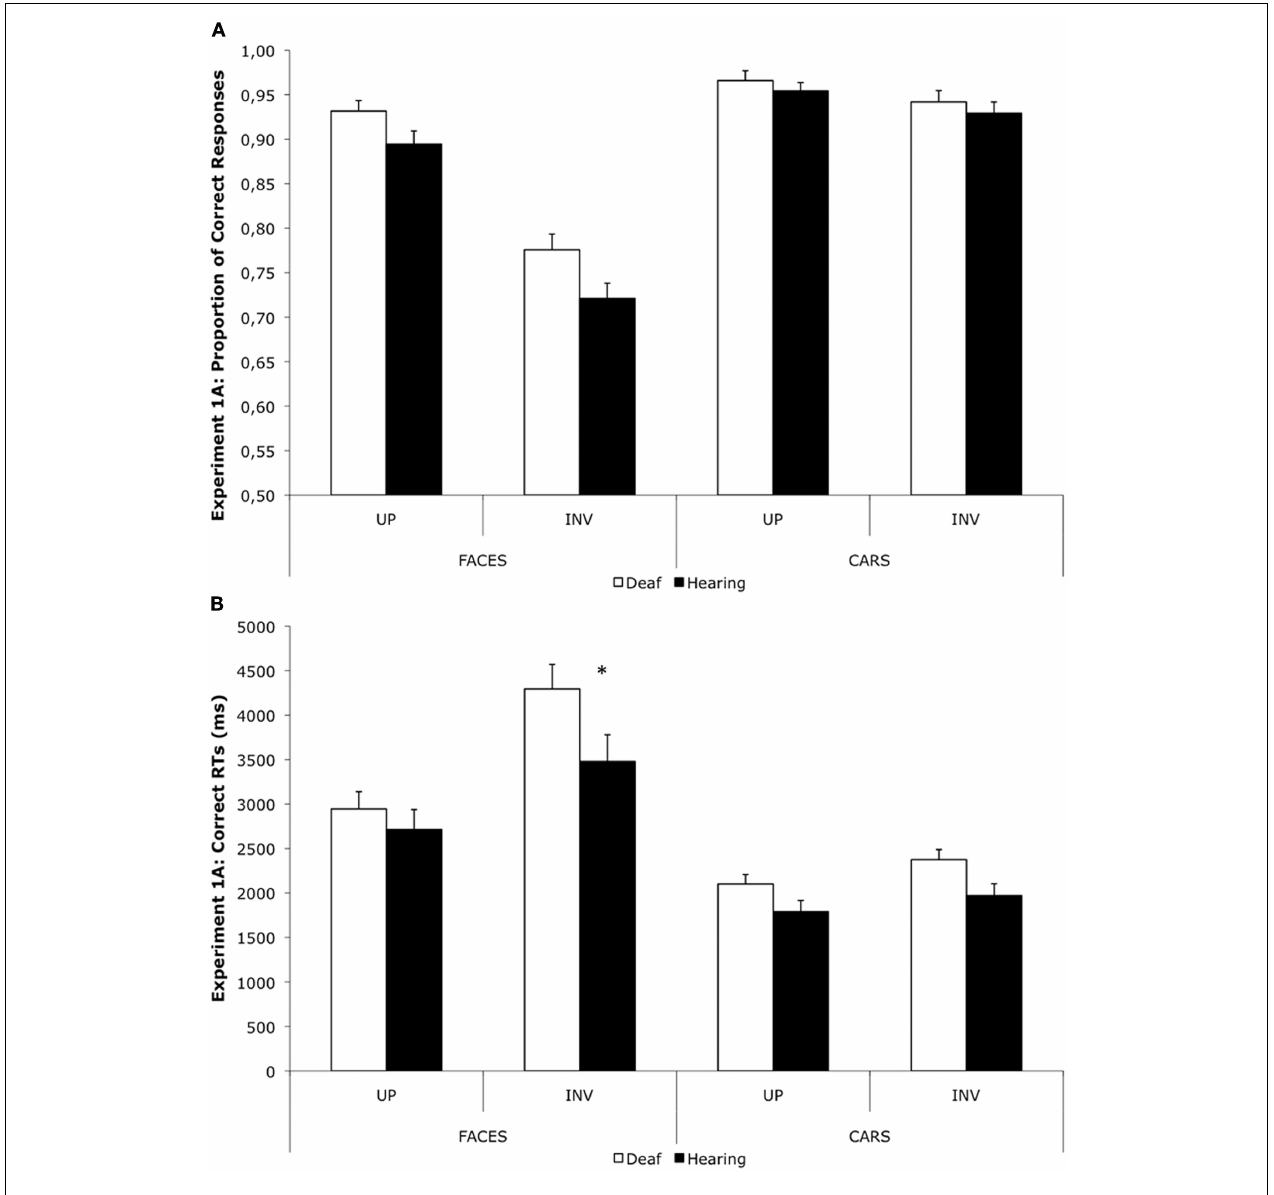
simultaneously on the screen (Experiment 1A). Bars represent SEs. Asterisks indicate significant differences between the two groups ( p <